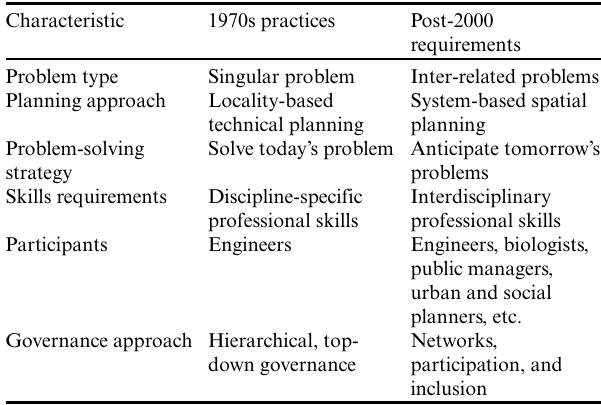
Table 1. Traditional and future water management and planning